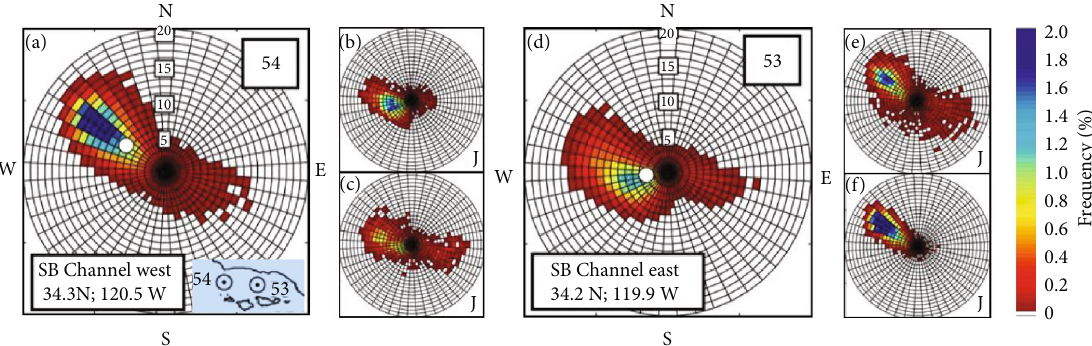
Figure 20: Wind roses for the NOAA East (46053 - labeled 54) Channel buoy for (a) full year, (b) winter (January), and (c) summer (June) and West (46053 - labeled 53) Channel buoy for (d) full year, (e) winter (January), and (f) summer (June). Adapted from Beckenbach